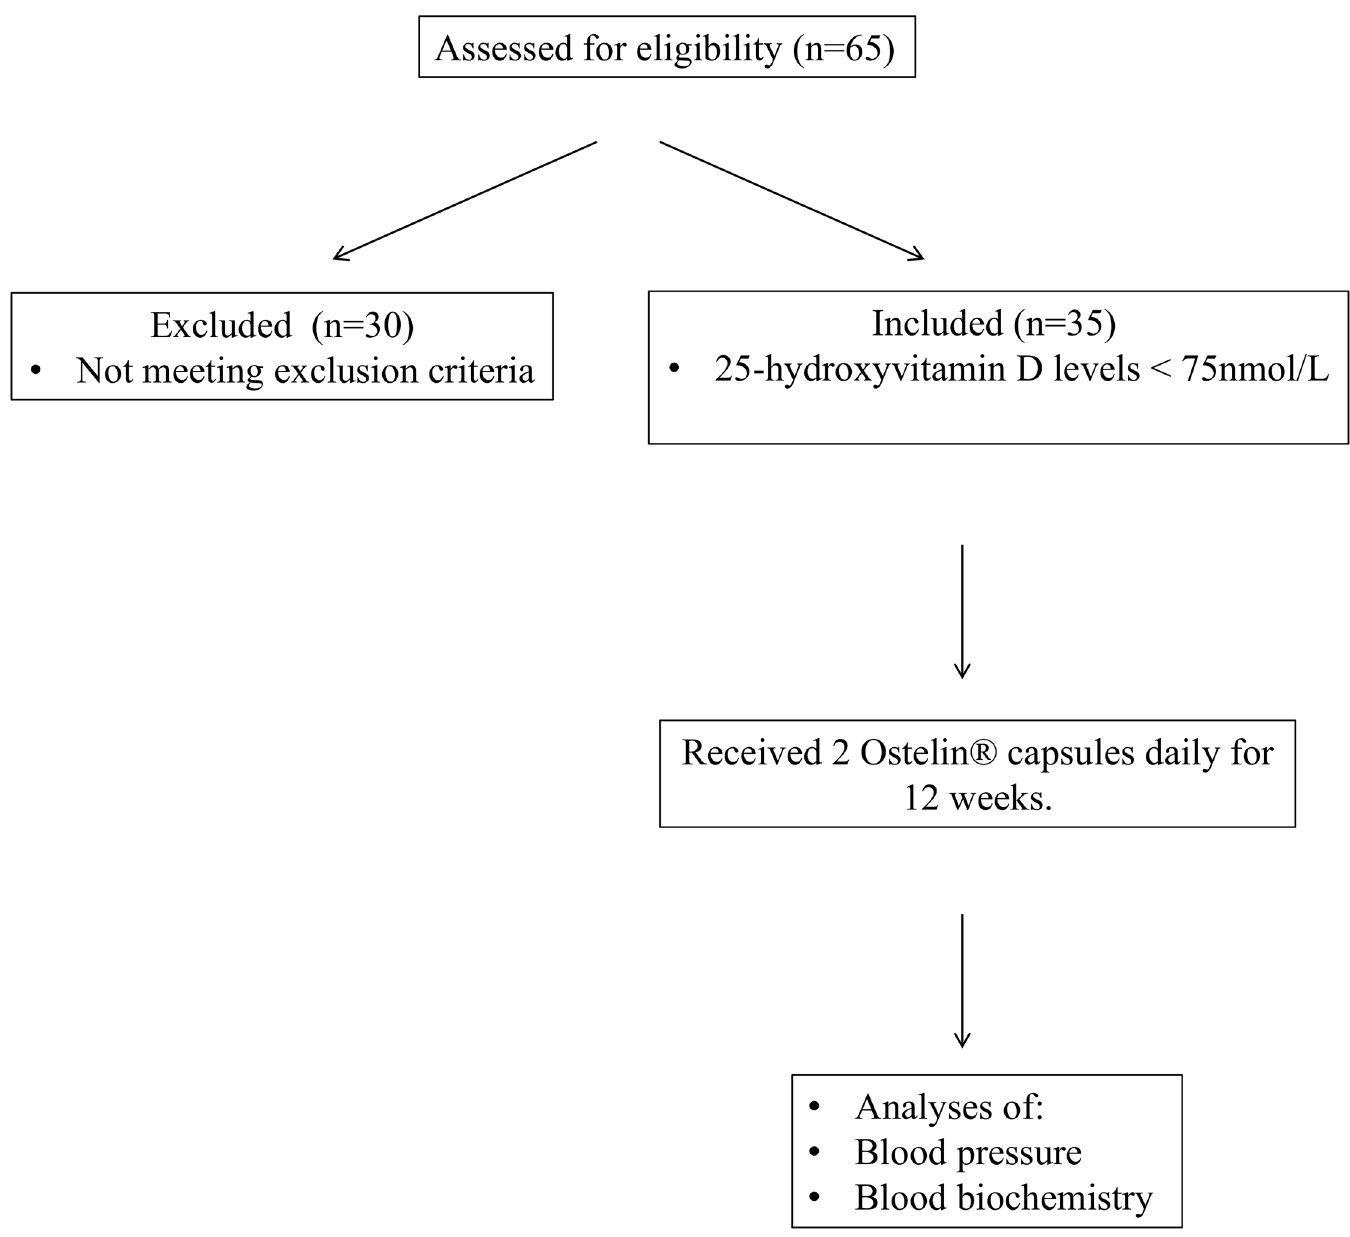
Fig 1. Study design